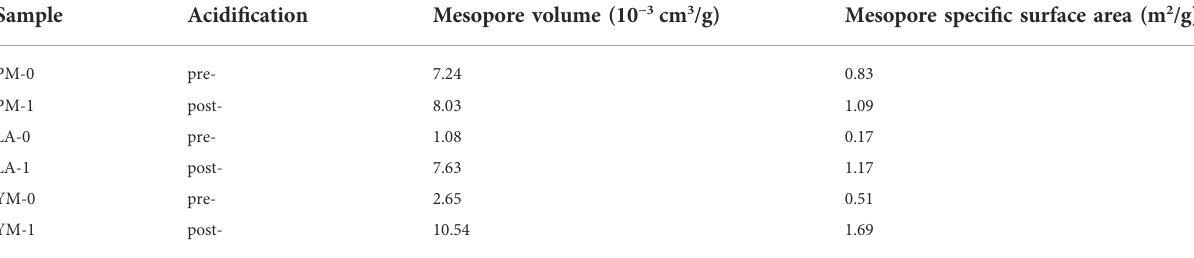
TABLE 2 Mesopore structural parameters of the raw and acidi fi ed coal samples from the LTGA-N 2 measurement.